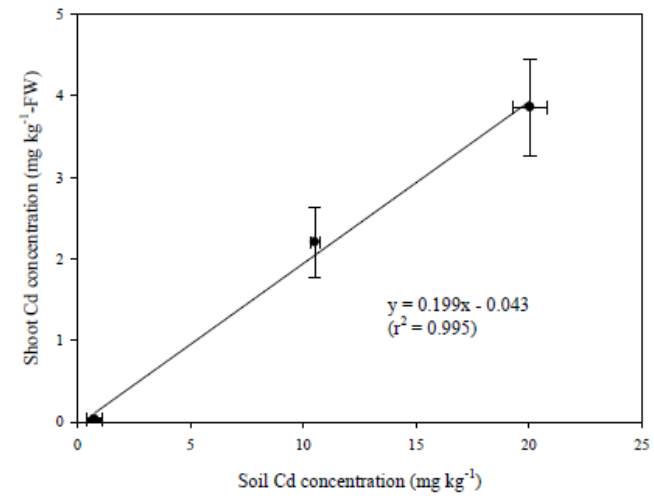
Figure 7. Linear relationship between Cd concentrations in soils and that in the edible parts of pak choi grown in various Cd-contaminated soils for 50